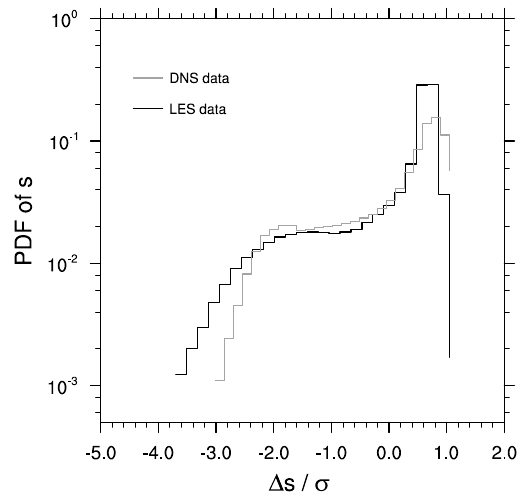
Fig. 2. PDF of s from LES data of DYCOMS and from a DNS study. Both PDFs are calculated at a height level close to the cloud top where the variance of horizontal winds are at their respective maximum. The DNS data corresponds to a local study of turbulent mixing at cloud top, due solely to evaporative cooling (Mellado et al., 2010).